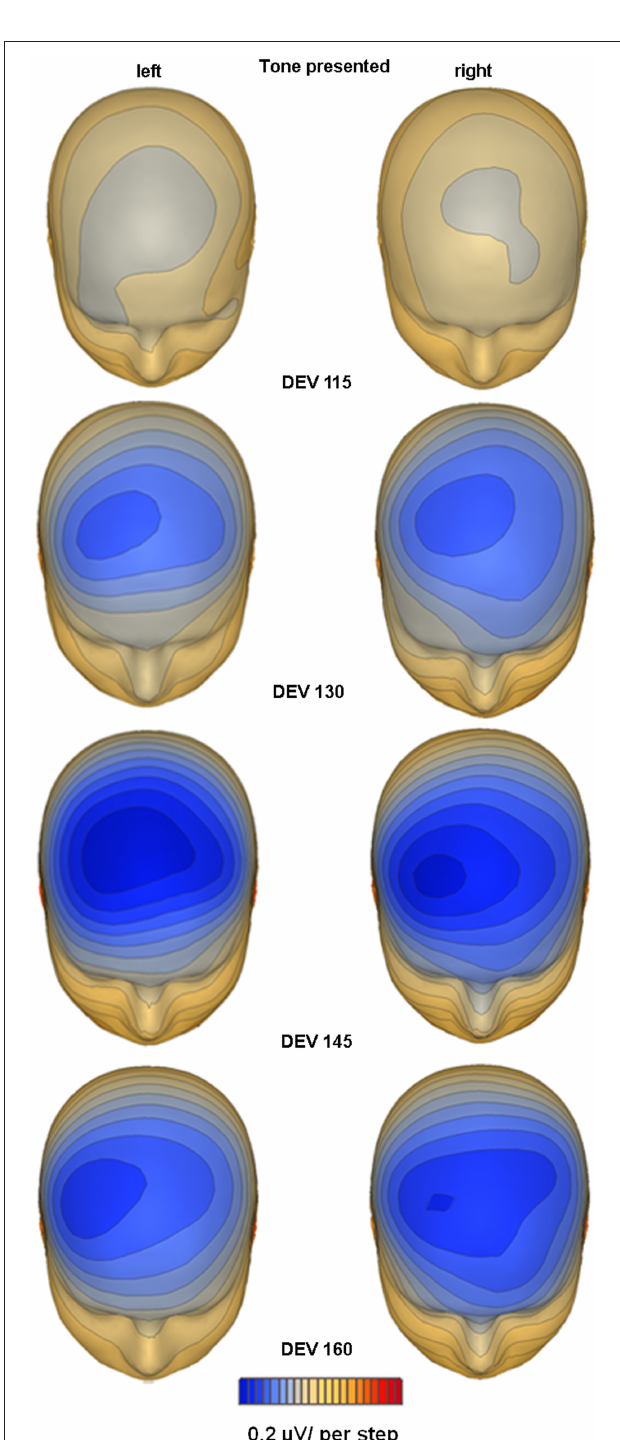
FIGURE 3 | Topographic mapping of spline-interpolated potential distribution representing the MMN response as subtraction waveform (deviant − standard). The MMN is plotted at peak latency for each ear of delivery and degree of deviance separately. A distinct lateralization of the duration MMN focus over the right hemi-scalp is evident in each condition, except for the condition where no signifi cant MMN activation was evident, e.g. the smallest degree of deviance present to the right